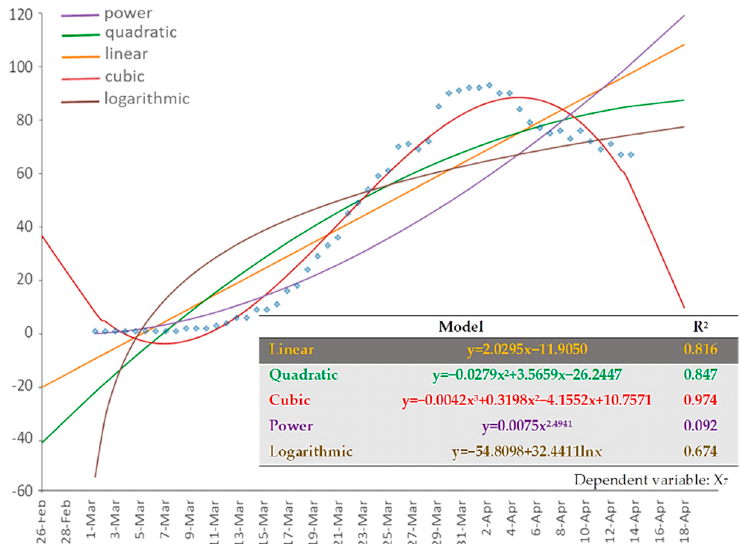
Figure 8. The available types of fitting curves applied to the cumulative COVID ‐ 19 ICU patients (variable: cumulative X 7 ) of Greece. Time ‐ series data of the variable are shown in dots.